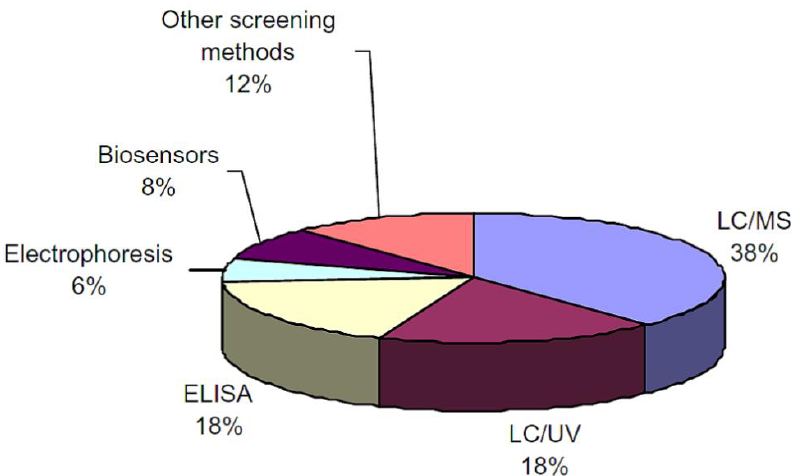
Figure 2. Analytical methods classification used for antibiotics determination in food